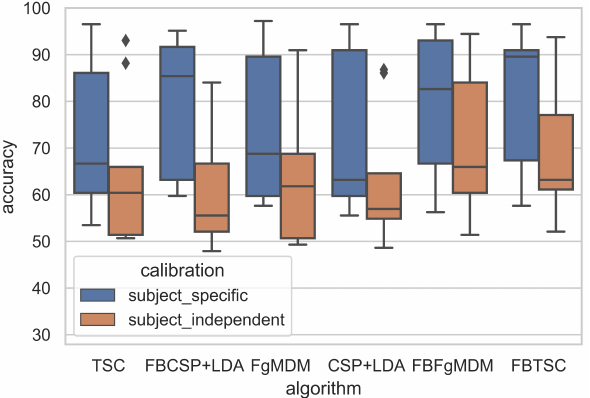
Figure 6. Classification accuracy of each algorithm on the “BCI competition IV data set 2a”, in both subject-specific and subject-independent calibrations.